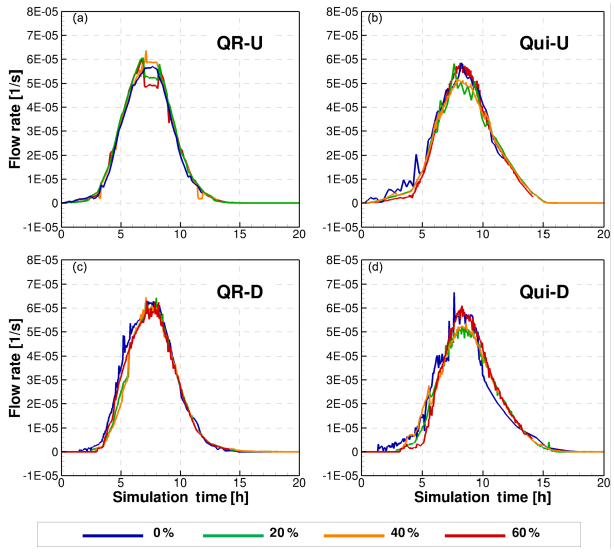
Figure 7. Normalized hydrographs at the gauged points upstream of the confluence. In panels (a) and (c) , we show the upper and lower zones in the Quebrada de Ramón stream, and panels (b) and (d) show the points at a similar elevation in the Quillayes